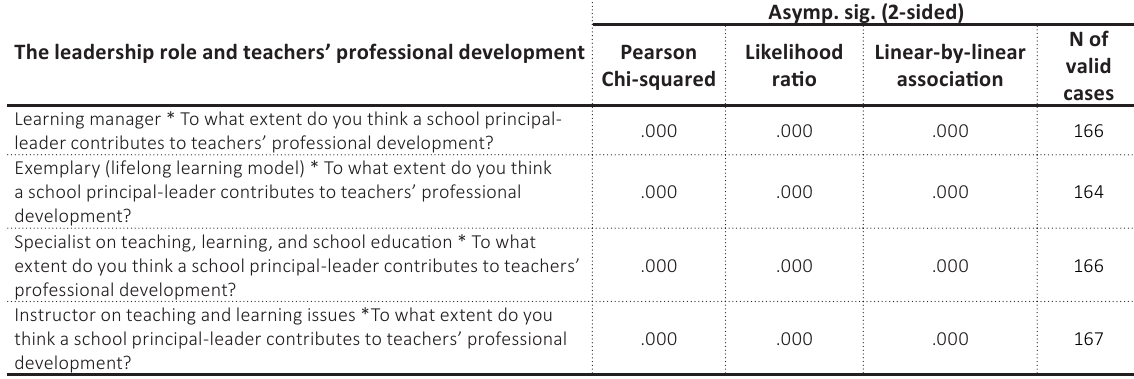
Table 9. Chi-squared analysis for hypothesis H